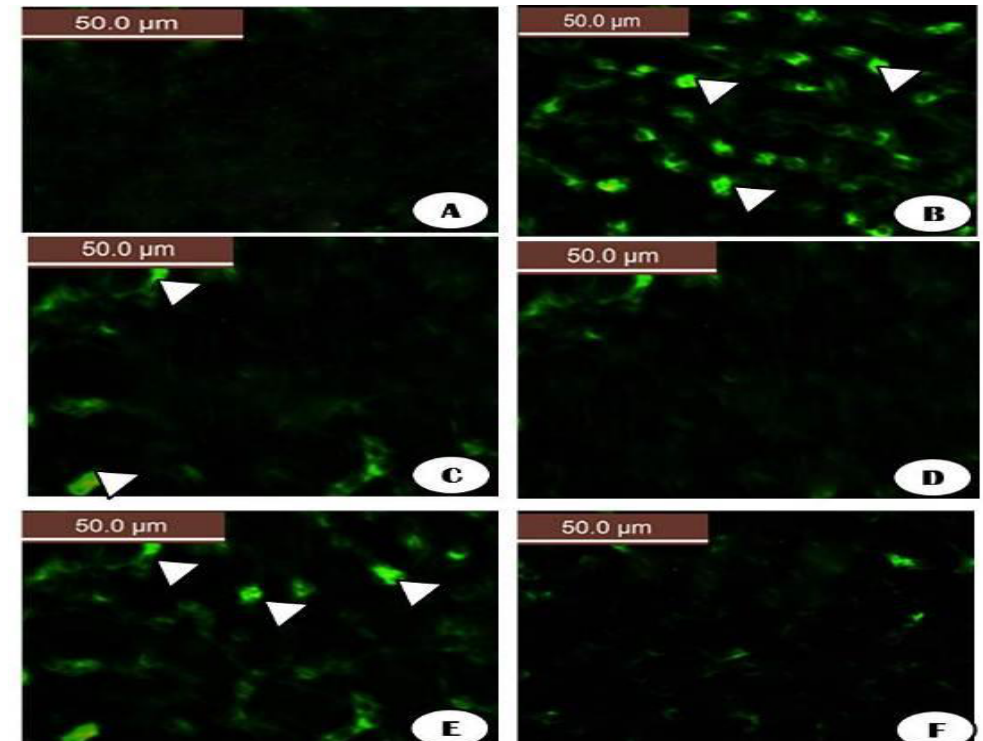
Figure 18. The fluorescent detection of mitochondrial membrane potential showed high improvement on the brain tissues treated groups ( A , C , D , F ) treated groups either control, Ru III /Q and DG combined with Ru III /Q showing non-accumulation of ROS in mitochondrial (50.0 µm). ( B ) DG treated group showing high accumulation of reactive oxygen species in the mitochondria as known that ROS accumulation is a hallmark of oxidative cell death (50.0 µm). ( E , F ) treated groups with DG in combination with either Q and/or Ru III /Q showing high amelioration in mitochondrial potential with very low reactive oxygen species accumulation (50.0 µm).